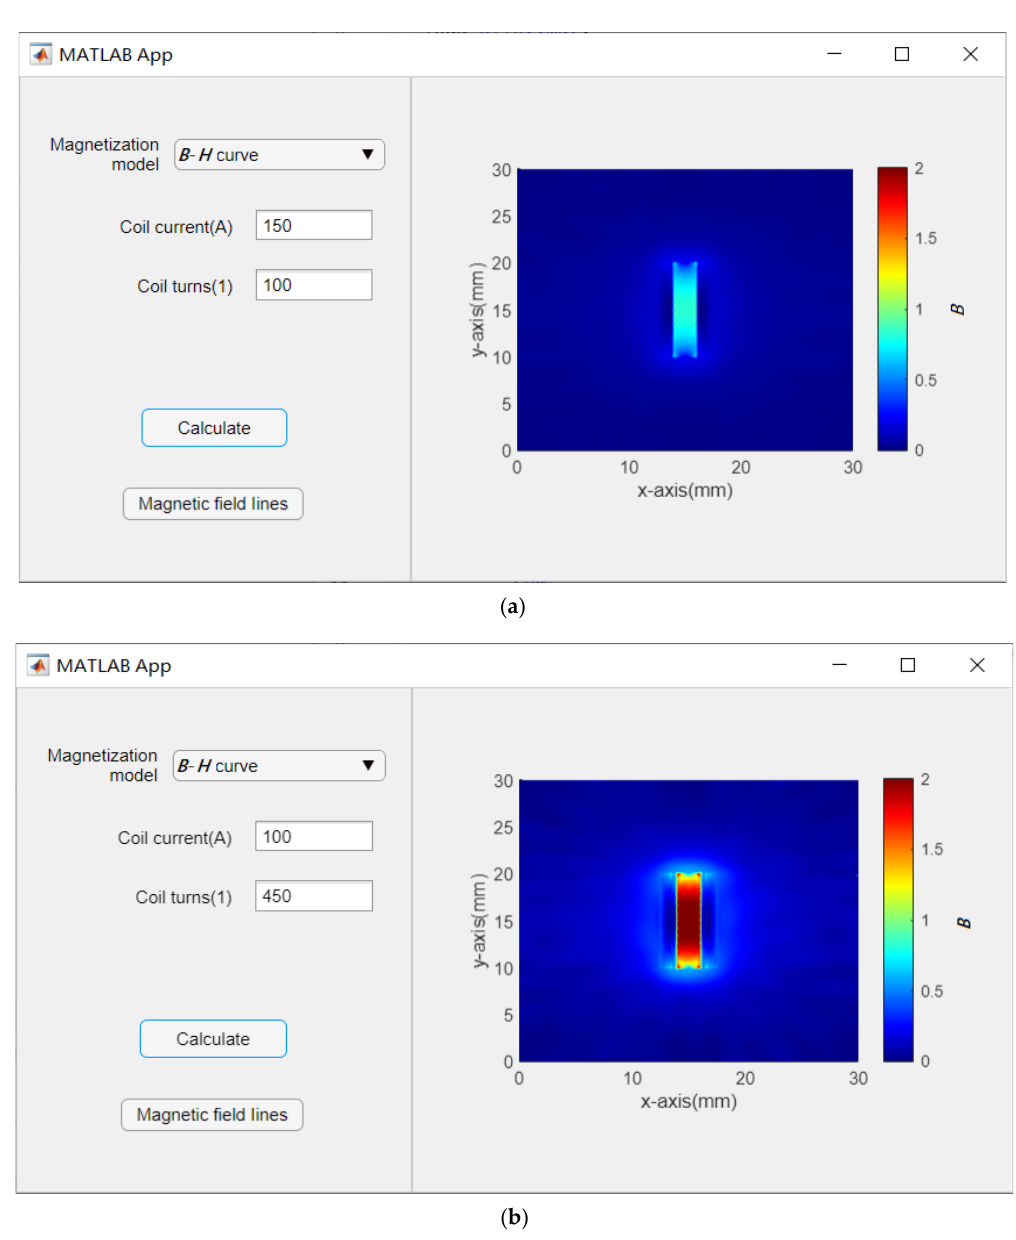
Figure 14. Neural network prediction results: ( a ) the magnetization model in the linear region of the B - H curve and ( b ) the magnetization model in the nonlinear region of the B - H curve.